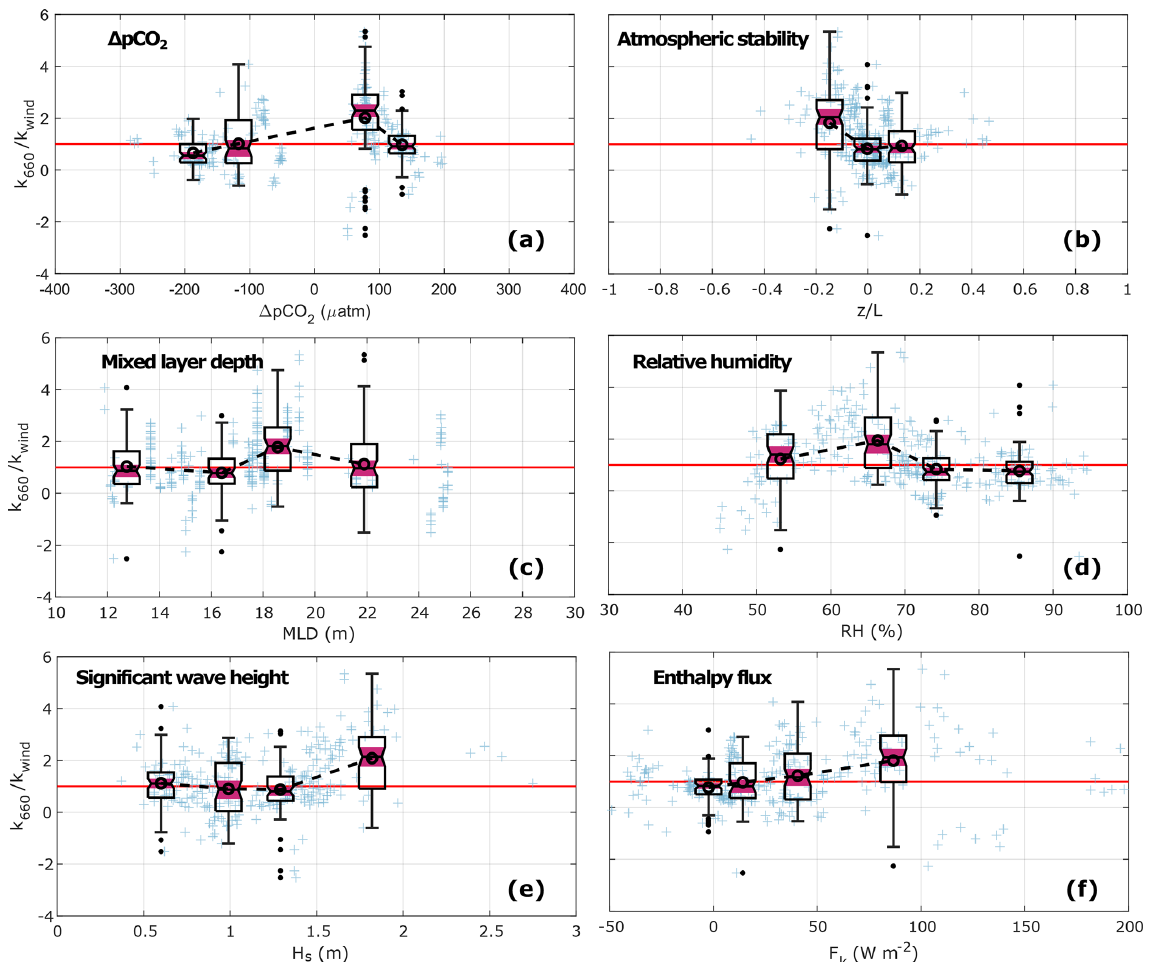
Figure 6. Normalized gas transfer velocity ( k 660 /k wind ) under high-wind-speed conditions ( U 10N > 8ms − 1 ) as a function of (a) (cid:49)p CO 2 , (b) atmospheric stability ( z/L ), (c) mixed-layer depth (MLD), (d) relative humidity (RH), (e) significant wave height ( H s ), and (f) total enthalpy flux ( F k ). The crosses represent the individual half-hourly values. The boxplots give a statistical summary for equidensity bins defined based on the distribution of k 660 /k wind as a function of each of the parameters (see Appendix A). The median, first, and third quartiles are represented in each box; the whiskers represent the minimum and maximum values, and the black dots represent the outliers; the notches highlighted in pink indicate the median’s 95% confidence interval. The open circles linked with a dashed line indicate the bin means, and the horizontal red line indicates k 660 /k wind =